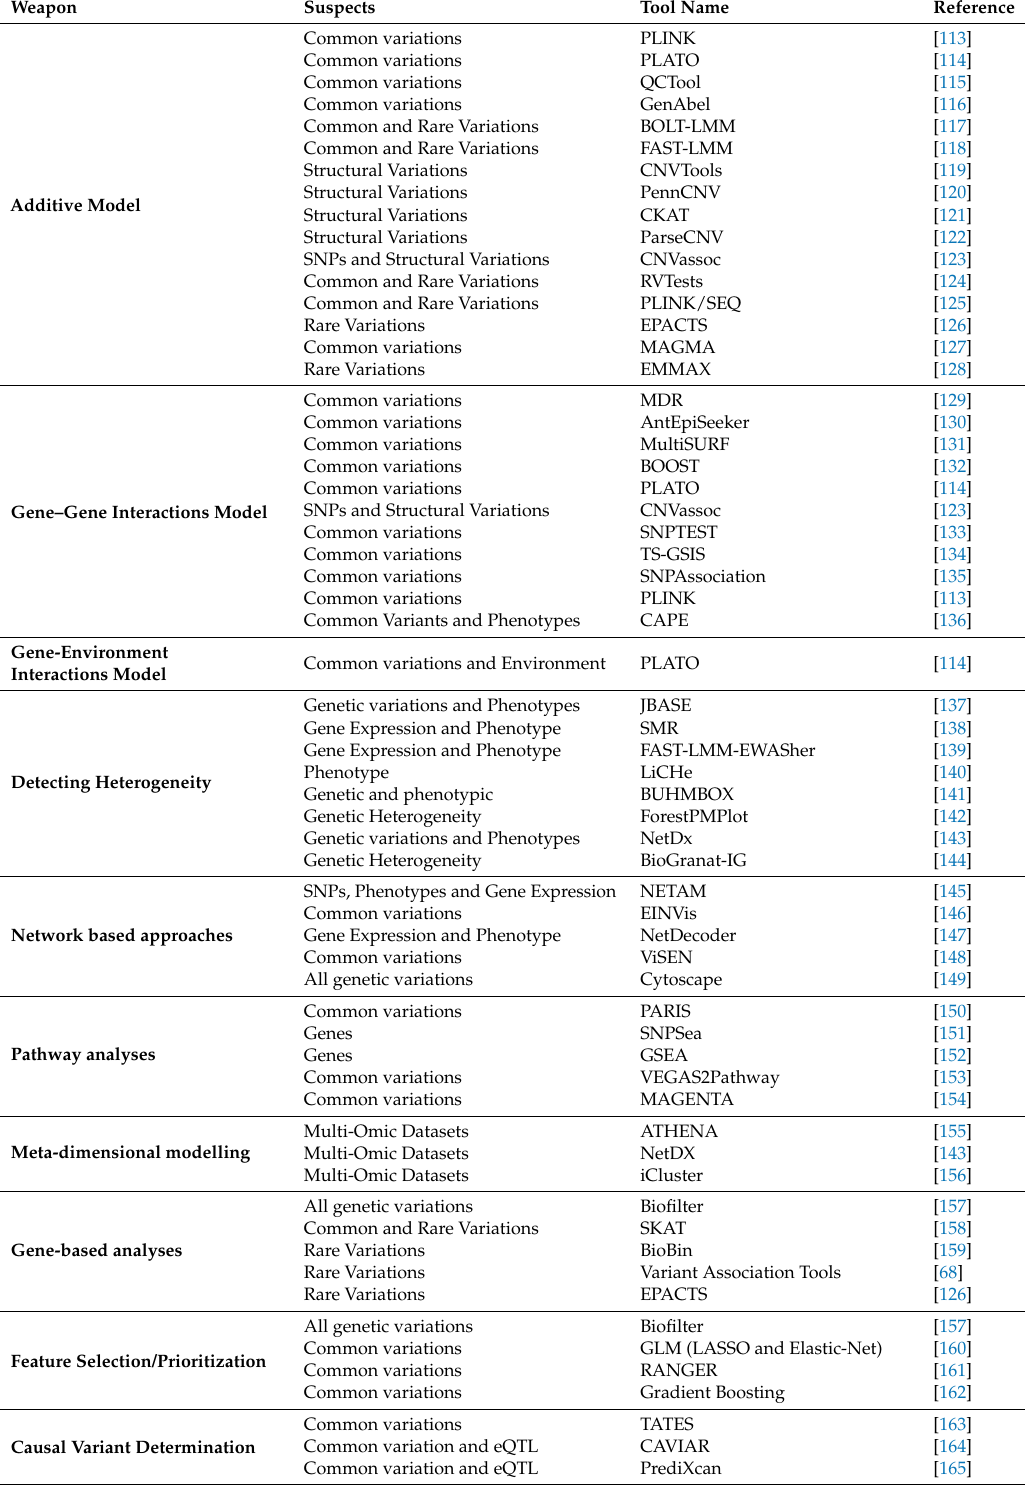
Table 1. A brief list of “weapons” (i.e., models/tools) available to identify genome-phenome associations to uncover heritability. Many of the tools are compiled from Omic Tools resource